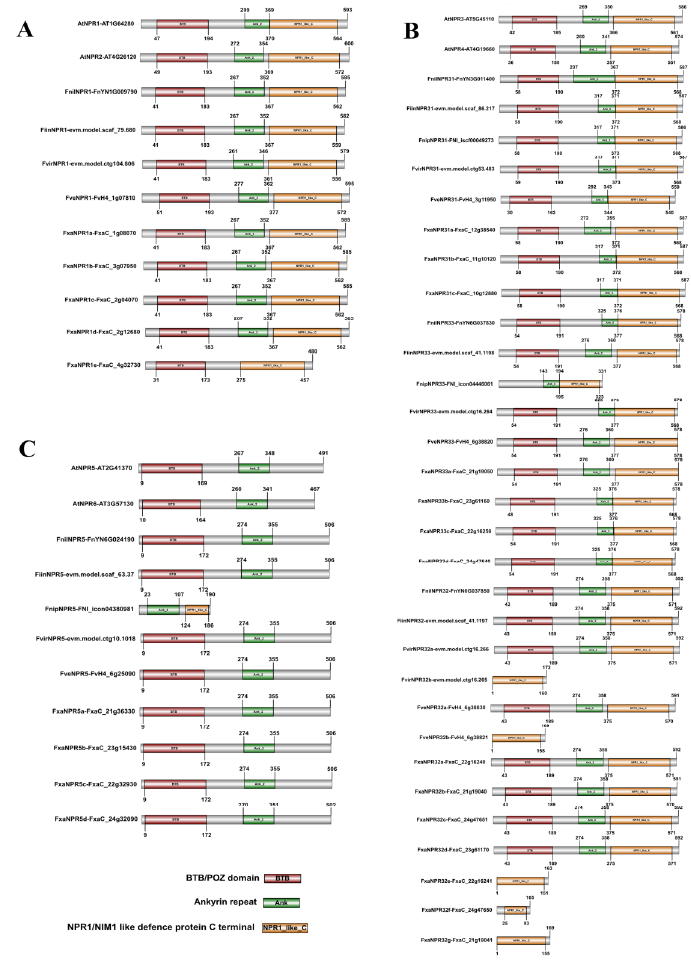
Figure 3. The comparative protein domain module of six AtNPRs and 48 strawberry NPR1-like se-